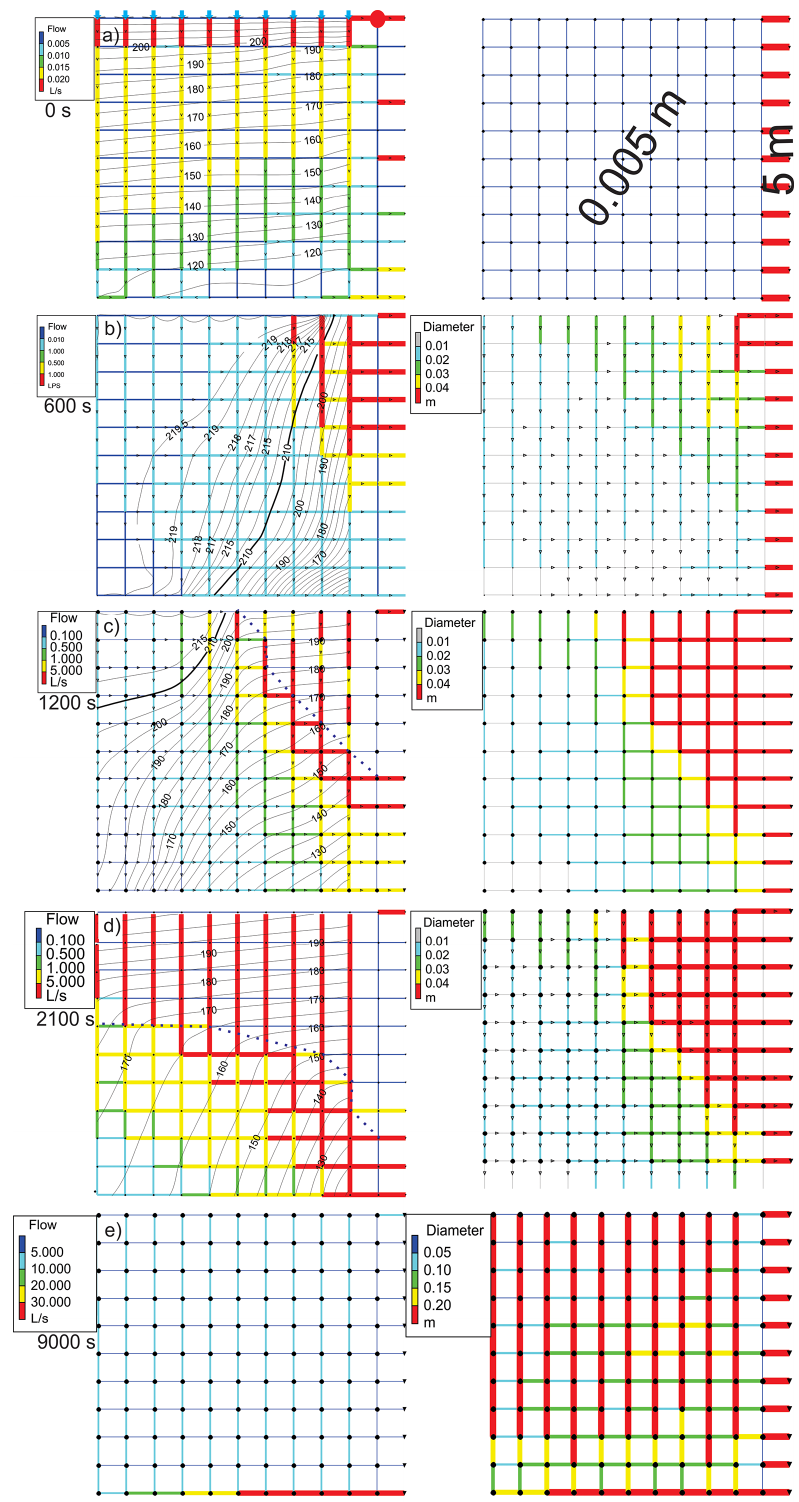
Figure 17. Evolution of homogenous sub-vertical network. Blue arrows on (a) denote inputs. Isolines and values present the hydraulic potential